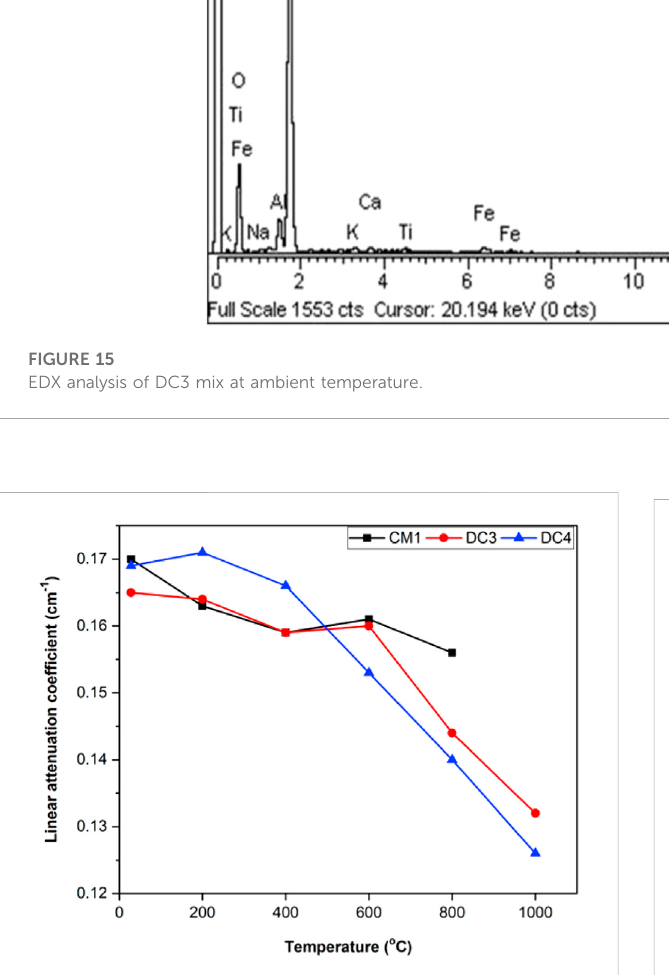
FIGURE 16 Linear Attenuation Coef fi cient (LAC) as function of temperature.